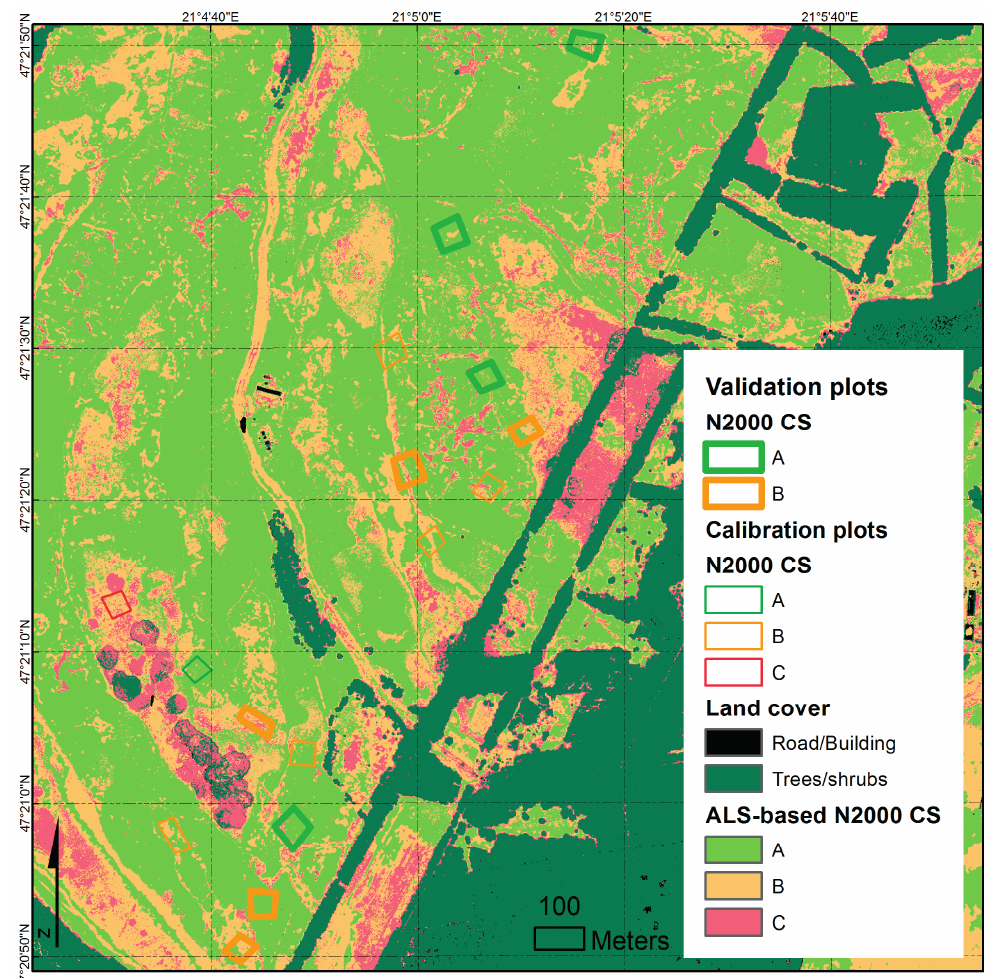
Figure 6. Cutout of the final CS map, showing some of the calibration and validation plots and the fine-scale CS patterns within